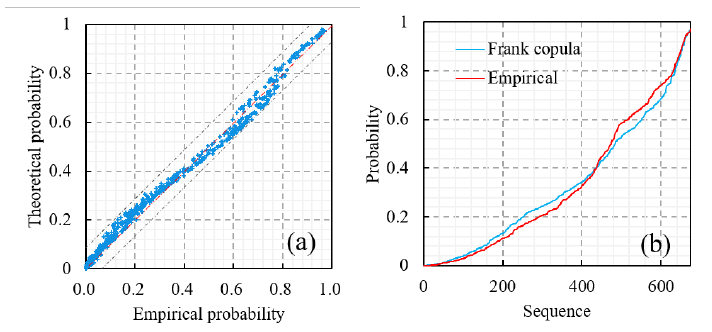
Figure 15. Comparison of theoretical and empirical probability with Frank copula: ( a ) Q-Q plots; ( b ) empirical and theoretical probabilities.